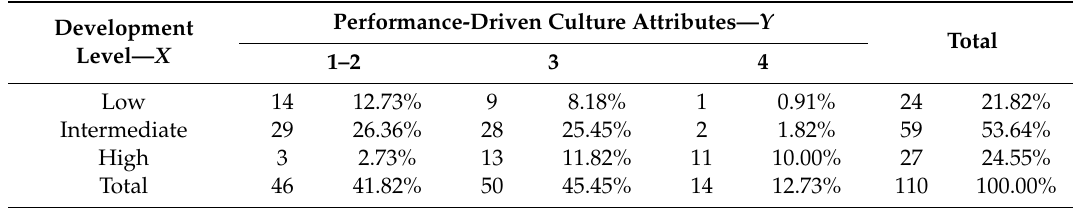
Table 5. Contingency table of absolute and relative (as % of the total) frequencies of PMM system development level and all performance-driven culture